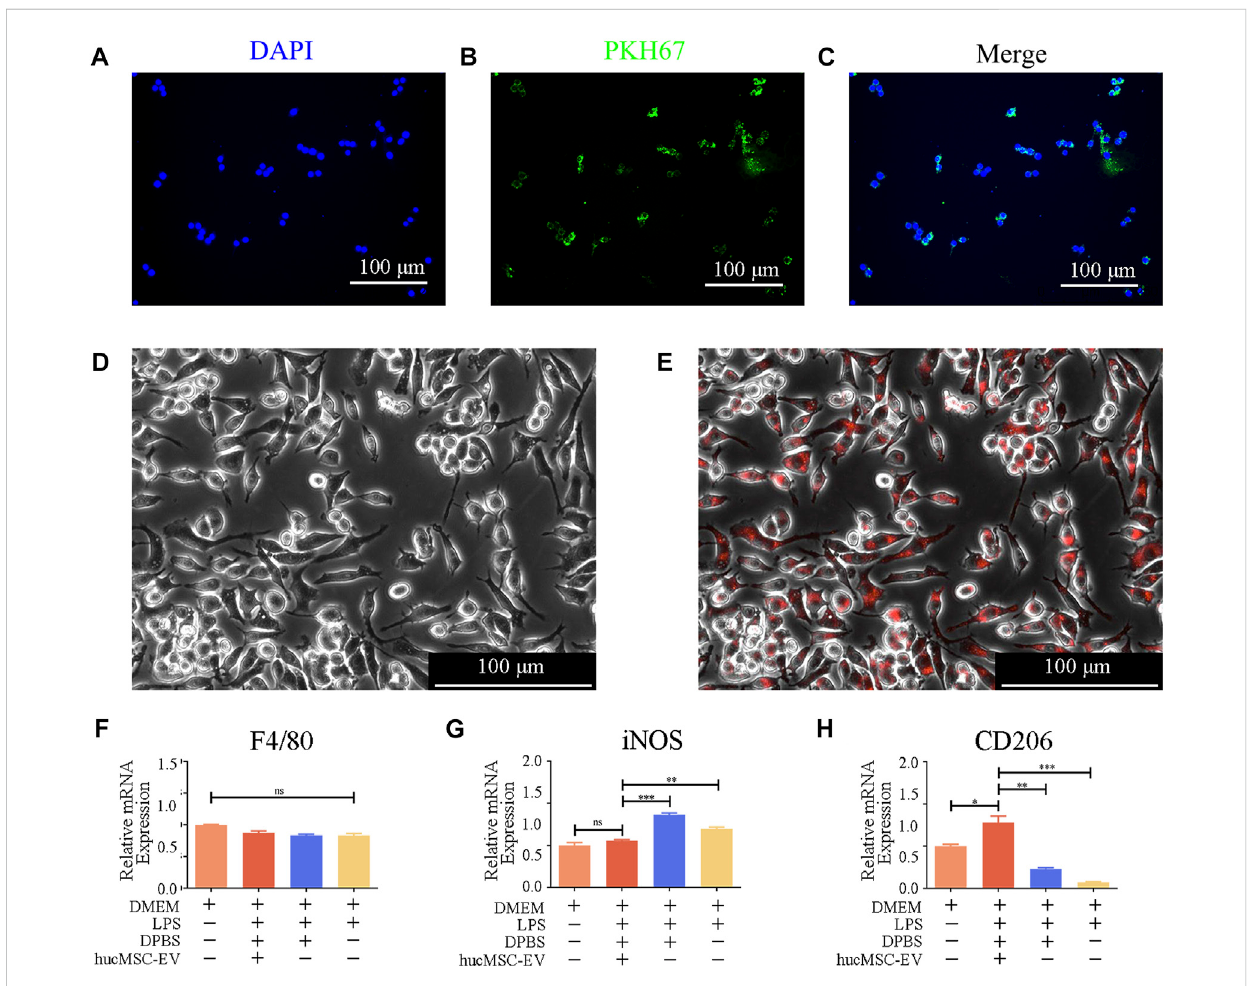
FIGURE 5 hucMSC-EV uptake by mouse RAW264.7 macrophages and hucMSC-EV-mediated polarization of RAW264.7 cells. (A – C) Immuno fl uorescence image showing the uptake of membrane components of hucMSC culture supernatant by RAW264.7 cells. (D, E) Immuno fl uorescence image indicating RAW264.7 cell uptake of hucMSC-EV. (F – H) Gene expression pro fi les of macrophage subtype markers in RAW264.7 cells in each group ( n = 3). Data are expressed as the mean ± SD. Statistical signi fi cance was determined using one-way ANOVA followed by an unpaired t-test or Kruskal – Wallis test. * p < .05, ** p < .01, *** p <